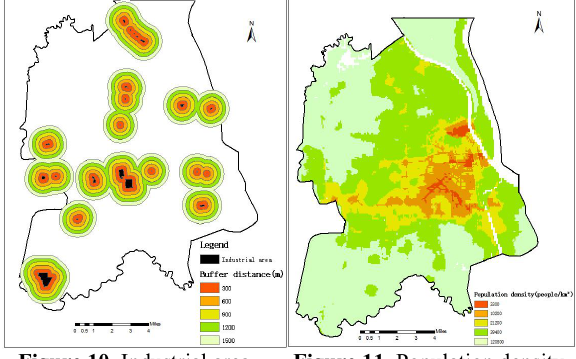
Figure 10. Industrial area. Figure 11. Population density.